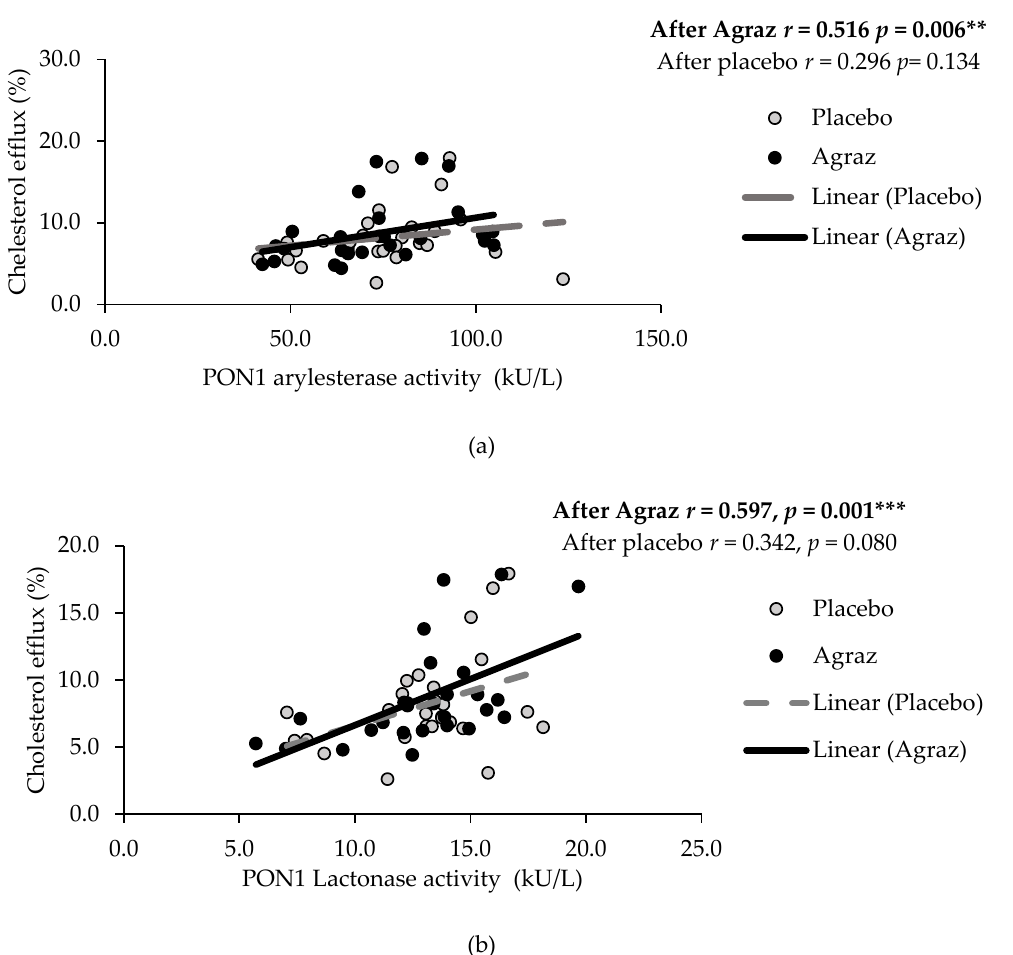
Figure 2. Spearman correlations between cholesterol efflux with ( a ) PON1 (paraoxonase 1) arylesterase and ( b ) lactonase activity after agraz consumption, compared to placebo. Significance * p < 0.05, ** p < 0.01, *** p < 0.001.